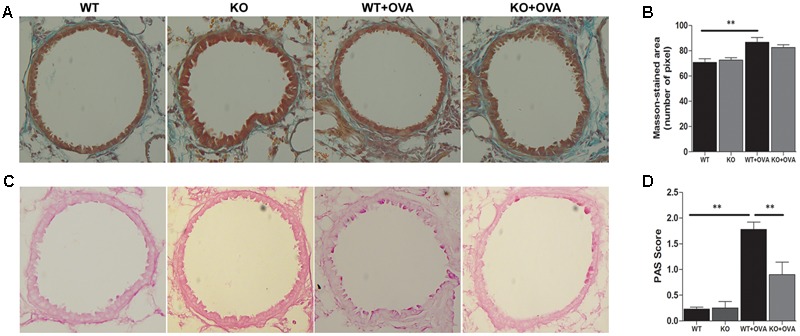
Gene deletion of KCa3.1 prevented established airway remodeling. (A) Representative images were obtained of Masson trichrome-stained lung sections from WT, KO, WT + OVA, and KO + OVA groups (original magnification, X 30). (B) Random measurements from the basement membrane into the submucosa (10 measurements of 20 μm in length) were taken, and the mean density was calculated from four bronchi per mouse (n = 5). ∗∗p < 0.01, one-way ANOVA followed by the Dunnett’s multiple comparison test compared with WT + OVA mice. (C) Representative images were obtained of PAS-stained lung sections from WT, KO, WT + OVA, and KO + OVA groups (original magnification, X 30). (D) PAS-stained sections were scored. Data were presented as means ± SEM (n = 5). ∗∗p < 0.01, one-way ANOVA followed by the Dunnett’s multiple comparison test compared with WT + OVA mice. WT, wildtype; KO, knockout.